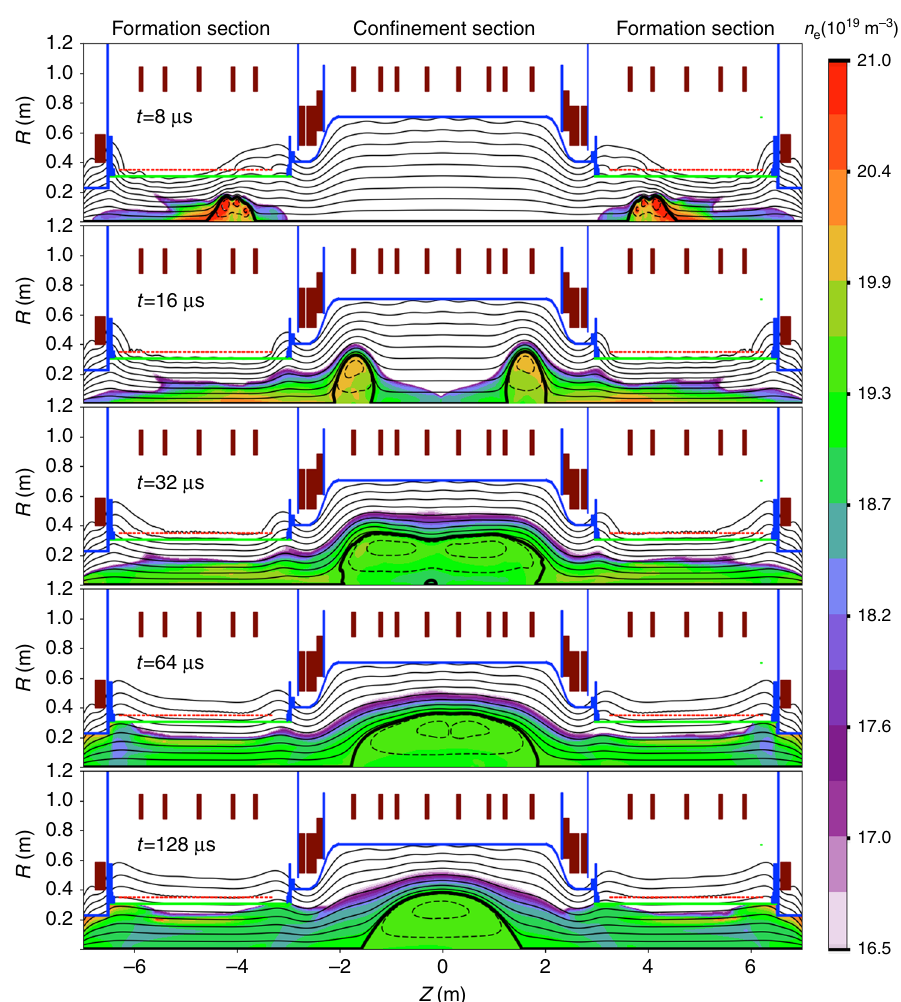
Fig. 2 MHD simulation of a typical FRC process in the C-2U device. Two FRCs are created in two quartz formation sections. They are accelerated towards each other to collide and merge into a single FRC inside a stainless steel con fi nement chamber. The collision transforms the kinetic energy of both moving FRCs into thermal energy of a single, static FRC. Magnetic fi eld topology in the SOL (solid lines), closed fi eld region (broken lines) and separatrix (thick solid line) are shown along with colour-coded electron density. DC Magnets (brown blocks), fl ux conserver structures (blue), fast switching magnets (dotted red line) and quartz tube boundaries (green horizontal lines) are also shown for